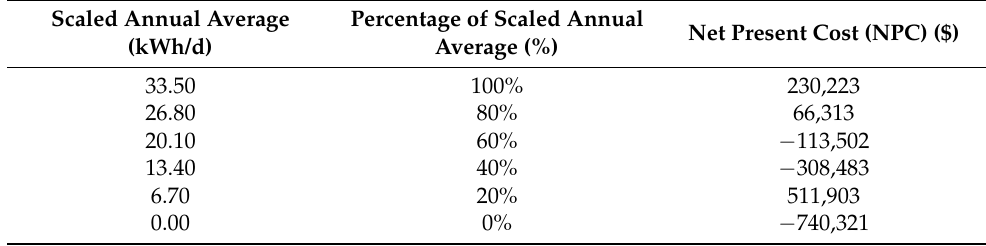
Table 4. Sensitivity analysis on scaled annual average of EV load.